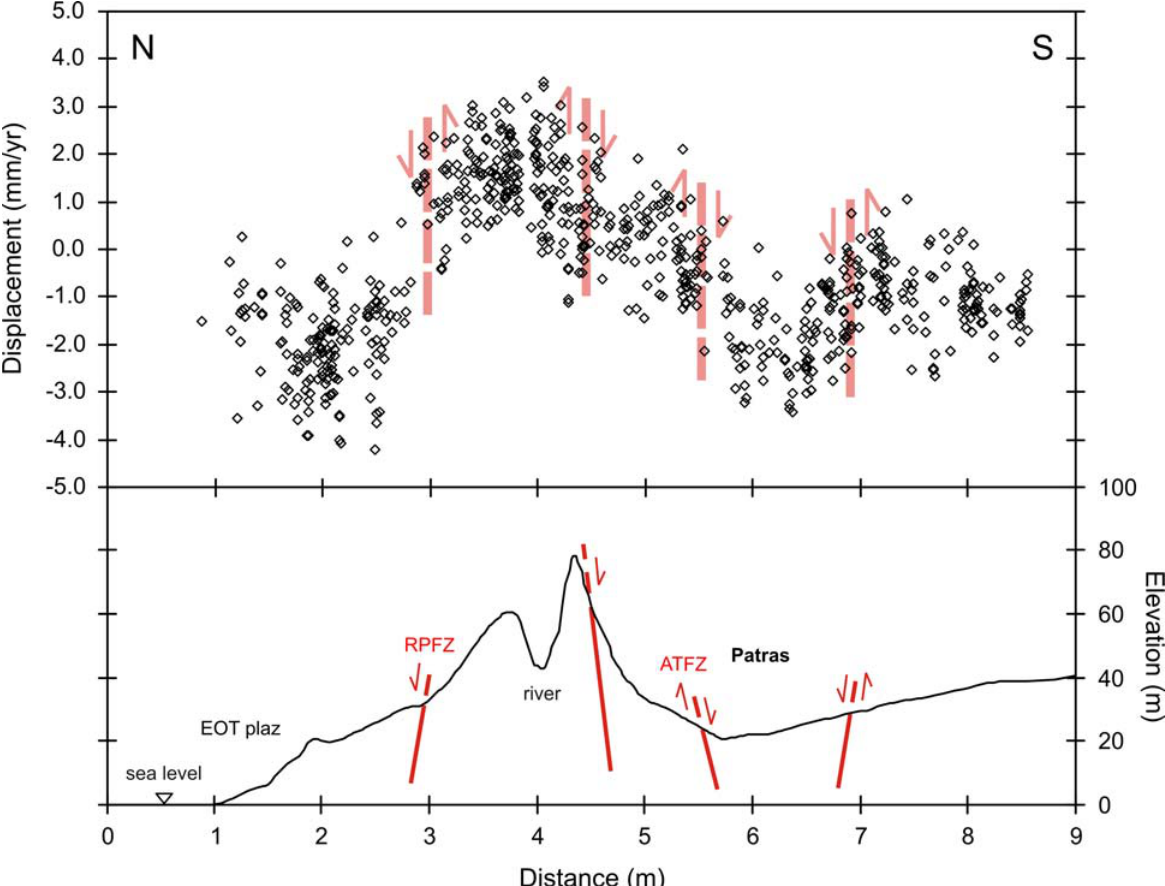
Figure 7. Spatial profile showing the displacement field as observed by IPTA and plotting targets within 150 meters in both sides of the profile (upper), and the related topography (down), red lines correspond to the